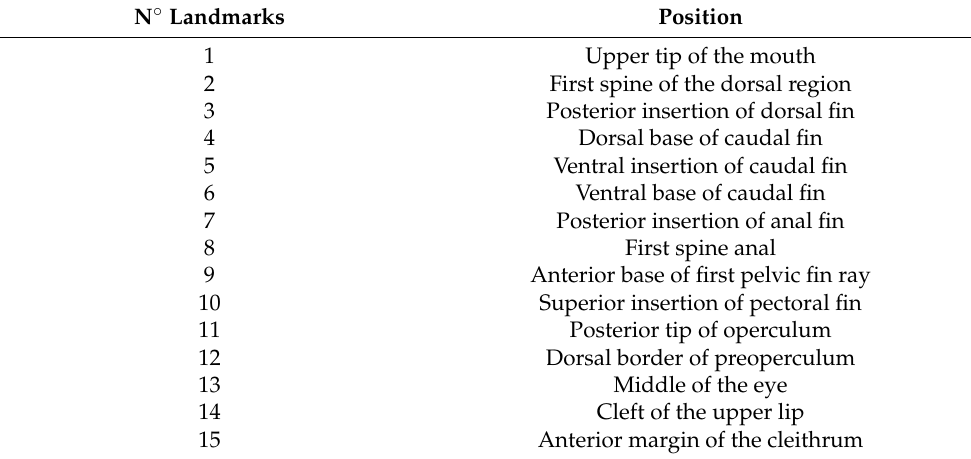
Table 1. Anatomical description of landmarks in C. kraussii